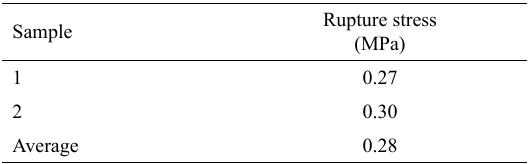
Table 5. Medium maximum values of the compression resistance of the mortar samples containing the basaltic